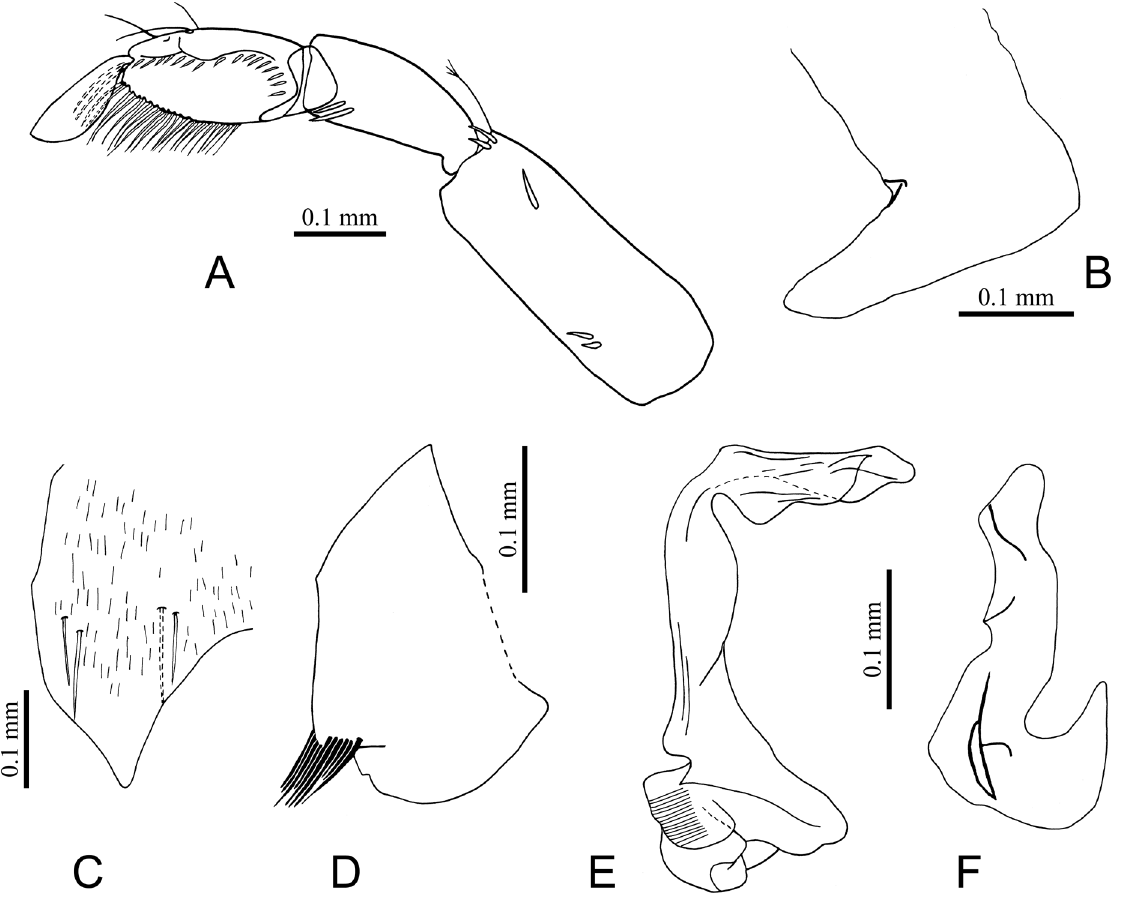
Fig. 18. Morphological features of Micronecta nieseri sp. nov., ♂, paratype (ZVNU). A . Fore leg. B . Prestrigilar flap. C . Median lobe of sternite VII. D . Free lobe. E . Right paramere. F . Left